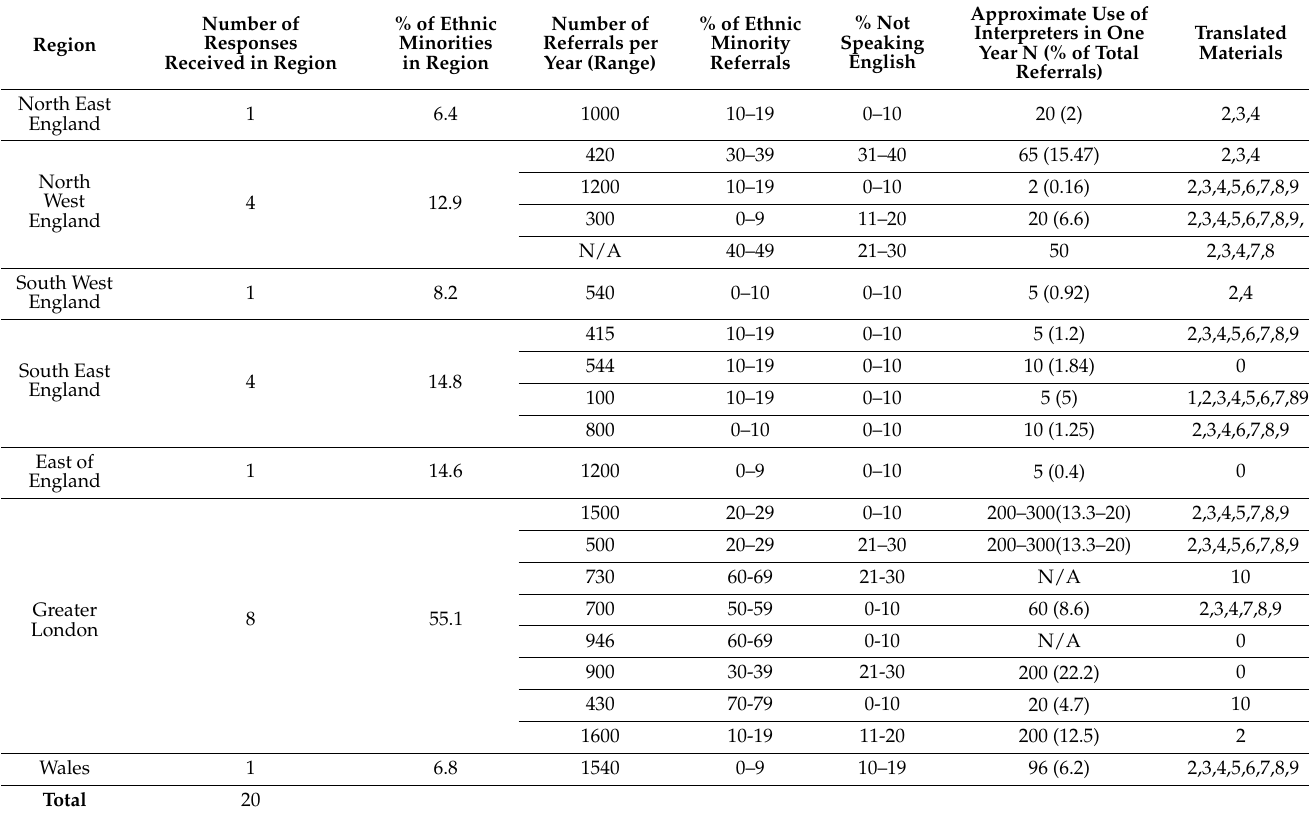
Table 1. Summary table with demographic information and its relation to the percentage of minority ethnic patients attending MAS and use of